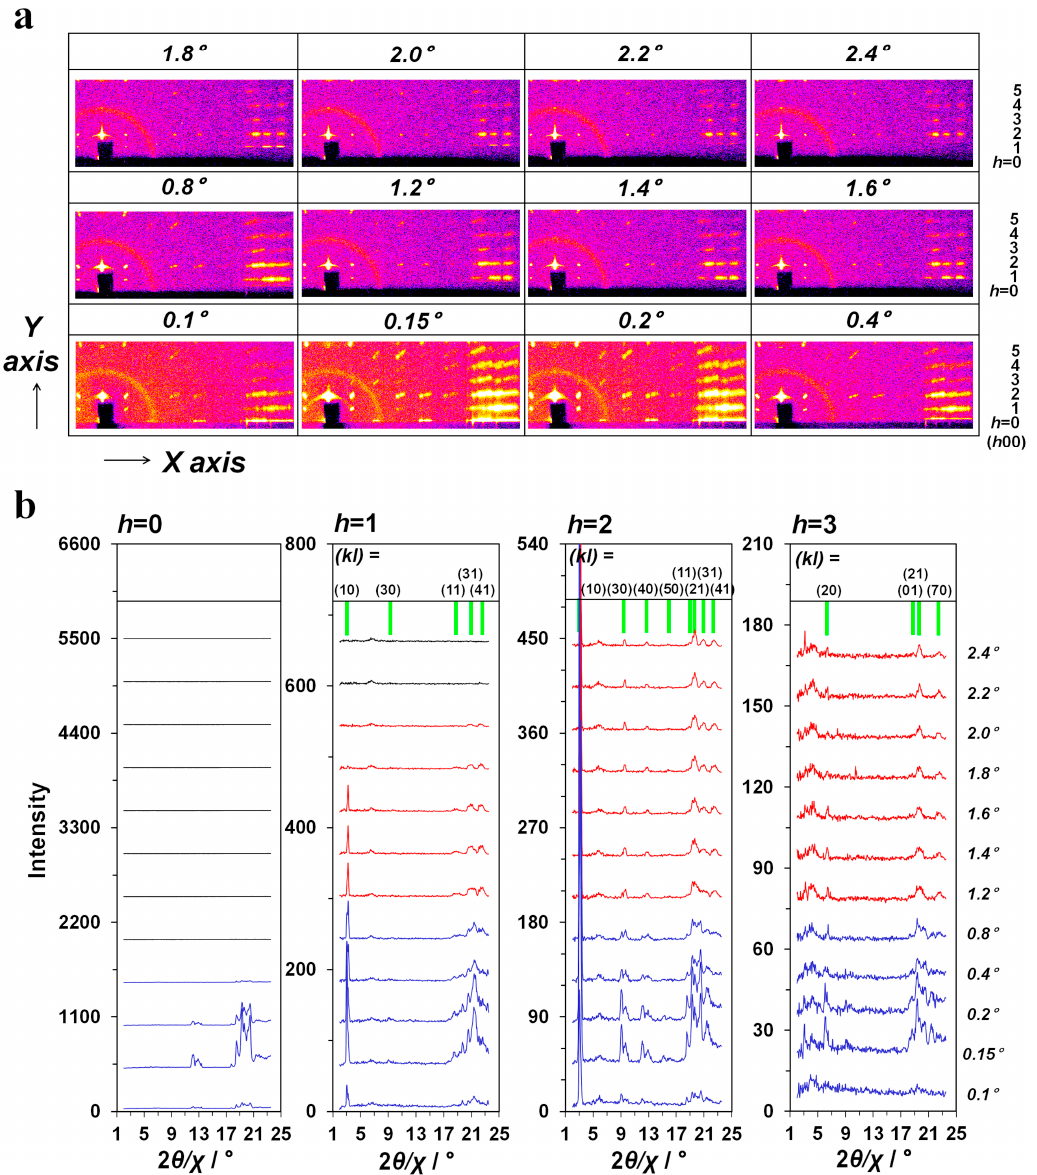
Figure 4. ( a ) GIXD images obtained for 640-nm-thick MO β Gal hemihydrate crystalline films with different incident angles and a fixed radiation time of 1800 s. ( b ) One-dimensional profiles derived by cutting the equatorial line from GIXD images at the (0 kl ), (1 kl ), (2 kl ), and (3 kl ) reflection planes, respectively. Black lines indicate that no reflections were observed.